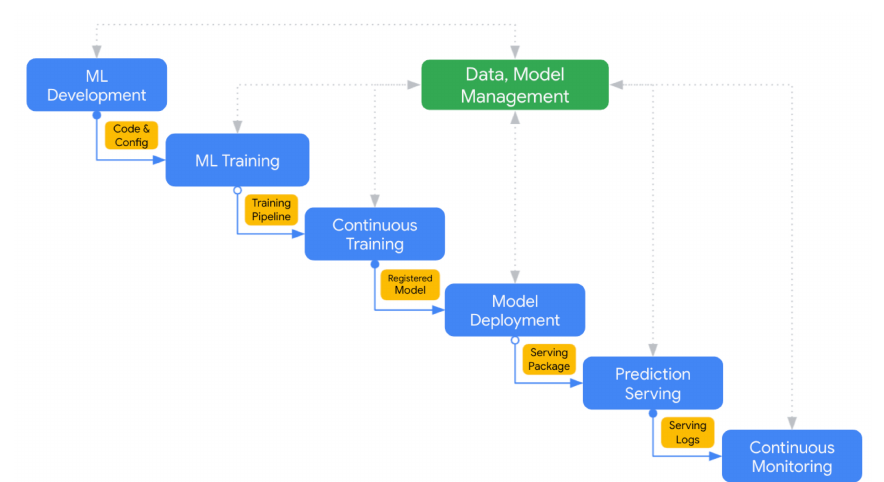
Figure 7. Scaling TinyML using MLOps. We present a systematic approach for devel- oping and deploying models into production. The MLOps stages are shown in a waterfall design, cascading down from one to another, which makes it easy to convey the important aspects within each stage. However, in practice, many organizations adopt an agile, iterative approach due to strong interdependencies that necessitate an agile